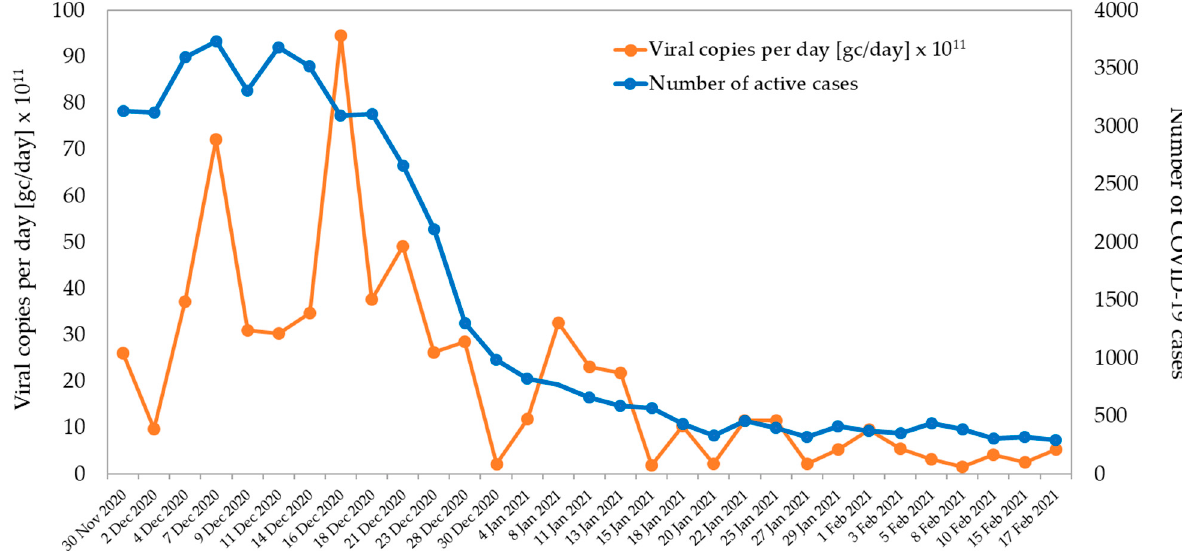
Figure 2. SARS-CoV-2 viral load in wastewater at the entrance to the Central Wastewater Treatment Plant of the City of